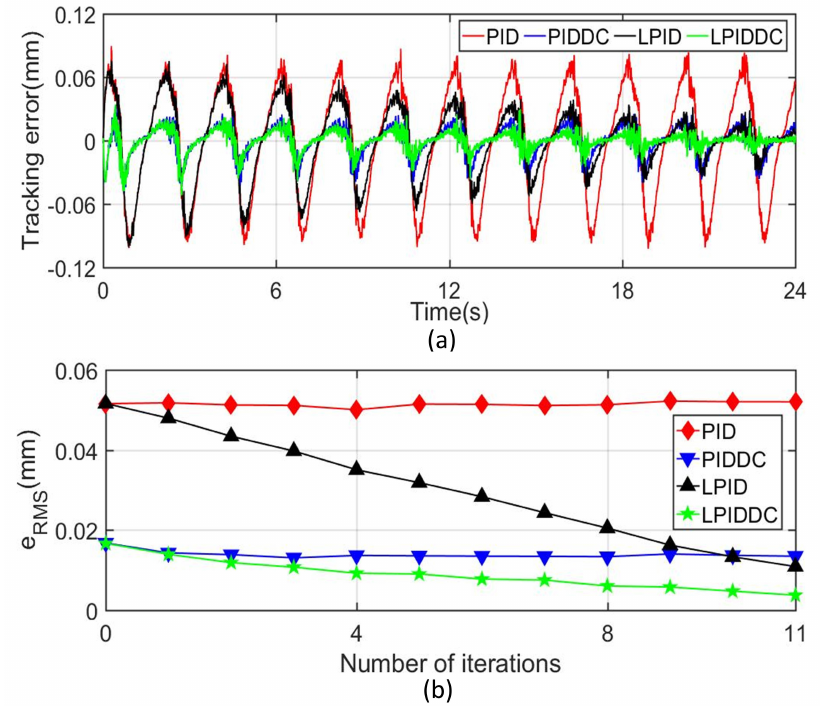
Figure 9. Tracking results of Track1 with polyfoam disturbance. ( a ) Tracking error in s z -axis. ( b ) Convergence rate of e RMS in s z -axis.